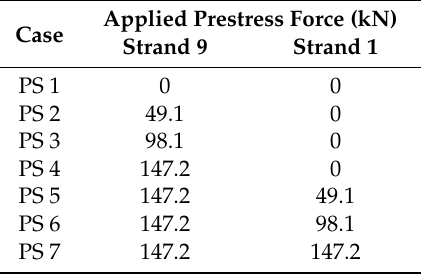
Table 6. Prestressing cases of the lab-scale multi-strand anchorage system.